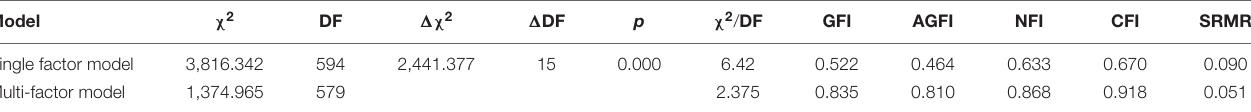
TABLE 1 | Difference between single-factor model and multi-factor model.